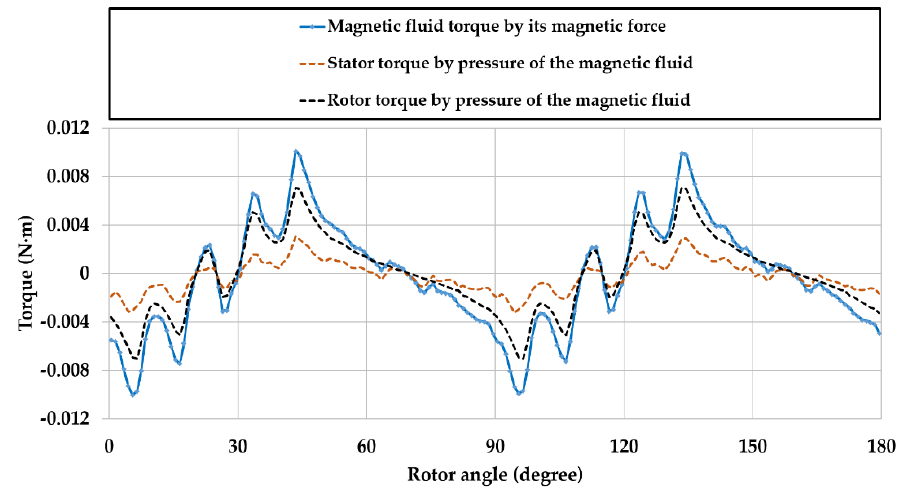
( θ ) , stator torque by pressure of the magnetic fluid τ pre 0 F ( θ ) of the experimental motor, according to rotor angle. Input current is 0 R